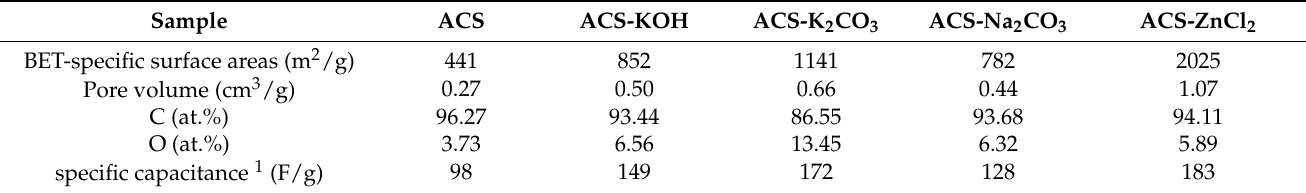
Table 1. The BET-specific surface areas, pore volume, surface element composition, and specific capacitance in three-electrode system of the carbon spheres activated with different activators.